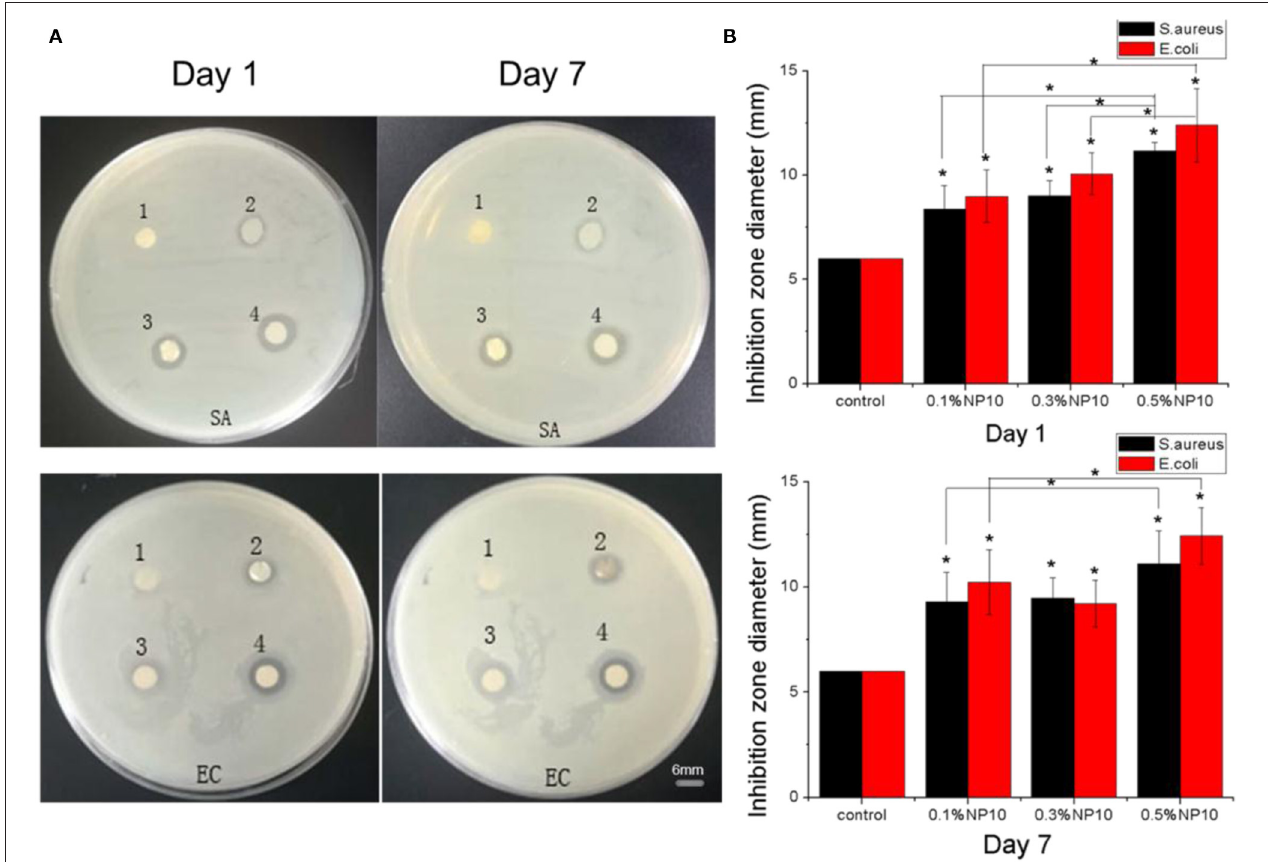
FIGURE 3 | (A) Inhibition zones of S. aureus and E. coli on the first and seventh days. The CS-PEO nanofiber membranes contains different amounts of NP10, where SA represents S. aureus and EC represents E. coli [(1) 0%; (2) 0.1%; (3) 0.3%; (4) 0.5% of NP10]. (B) Calculated suppression zone diameter in (A) . Compared with the control group and between the experimental group, * P <